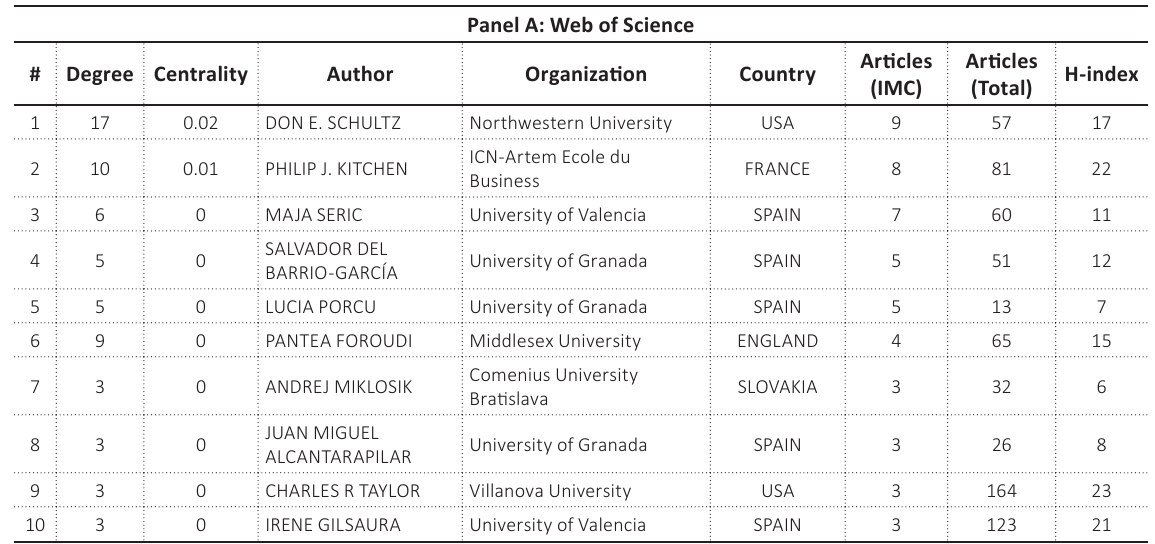
Table 4. The most cited authors in IMC research